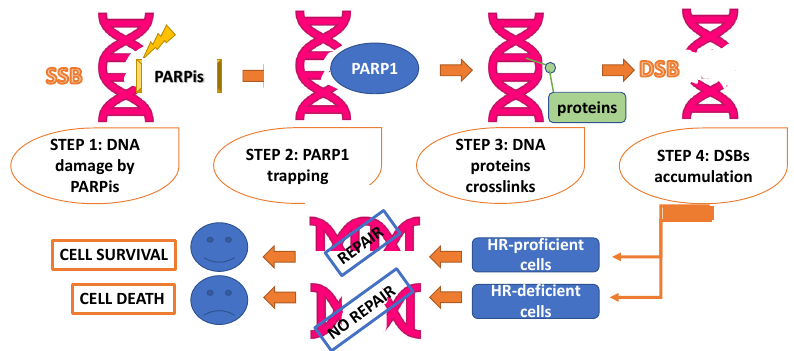
Figure 1. Mechanism of action of polyADP-ribose polymerase (PARP) inhibitors. Step 1: DNA damage caused by PARP inhibitors, with consequent creation of single strand DNA break (SSB); Step 2: detection of SSB by PARP1; Step 3: production of DNA protein crosslinks; Step 4: collapse of replication forks and double strand DNA breaks (DSBs) accumulation. While in homologous recombination (HR)-proficient cells these errors are restored by HR system, in HR-deficient tumor cells this process finally results in cell death.